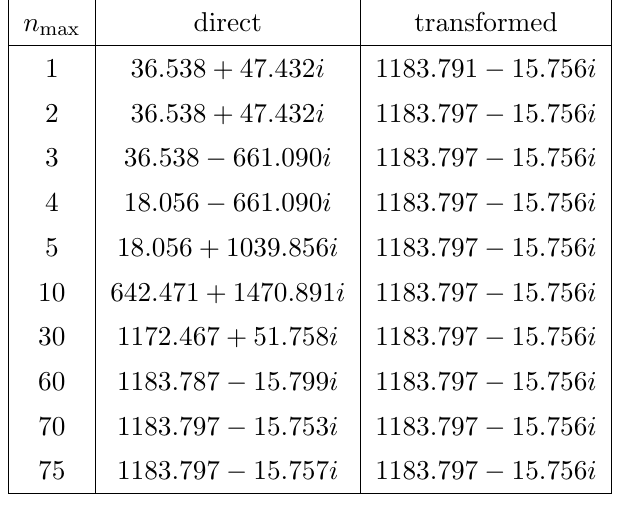
Table 1. Numerical evaluation of h (4) n max terms. The column labeled ‘direct’ is obtained by expanding h (4) the numbers in the column labeled ‘transformed’ are obtained by mapping (cid:28) to the fundamental domain before